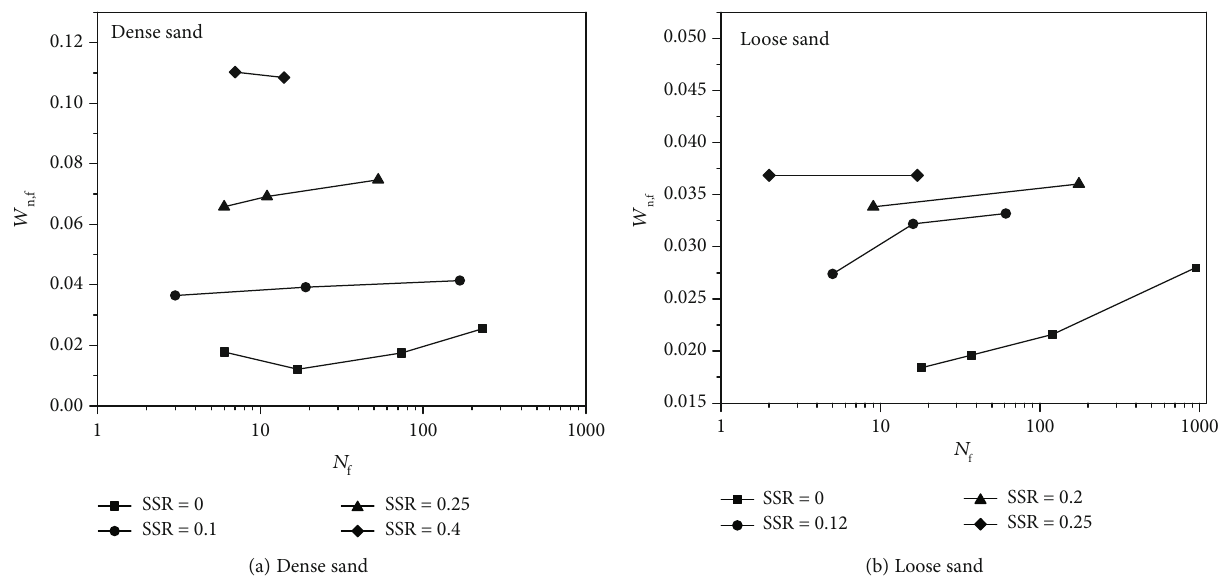
Figure 10: Relationship between dissipated energy and number of cycles required to cause liquefaction.